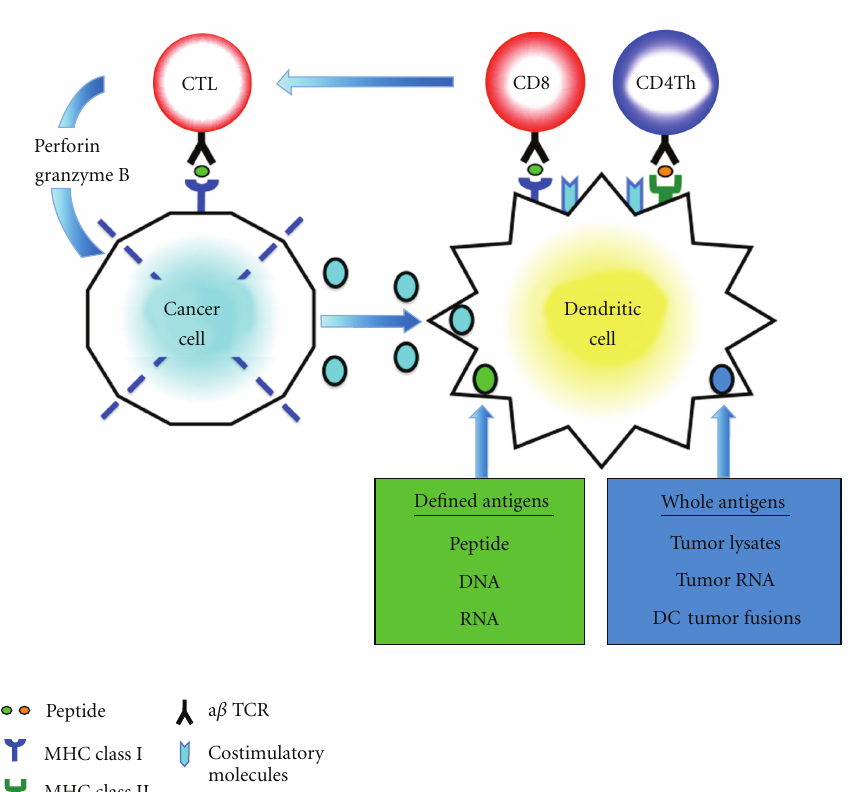
Figure 1: CTL induction by DCs. Antigens are taken up and degraded into peptide fragments by antigen-presenting cells, such as immature DCs. DCs process tumor-derived peptides and MHC class I peptides derived from DCs. They form MHC class I-peptide complexes, in the endoplasmic reticulum, which are transported to the surface of DCs and presented to CD8+ T cells. DCs also synthesize MHC class II peptides in the endoplasmic reticulum, which are transported to the cytoplasm where MHC class II-peptide complexes are assembled with tumor-derived peptides and presented to CD4+ T cells. The CD4+ T cells produce increased amounts of IL-2, which drives CD8+ T-cell proliferation. CD8+ T cells then become CTL, which can destroy cancer cells through e ff ector molecules such as granzyme B and